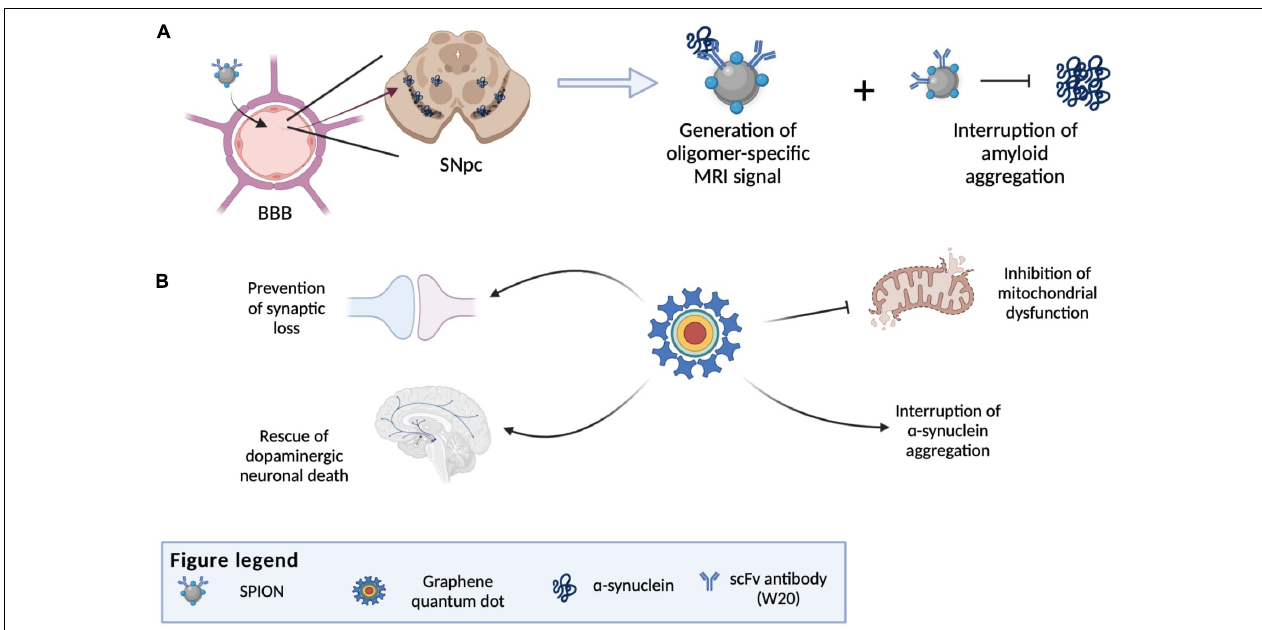
FIGURE 6 | Illustration of various nanotheranostic approaches targeting different stages of PD. (A) Illustration of antibody-conjugated SPION bypassing BBB due to receptor-mediated transcytosis and finally reaching the substantia nigra. SPIONS are able to bind to amyloid and generate an MRI signal (diagnostic) and at the same time interrupt further aggregation of amyloid. (B) Examples of applications of graphene quantum dots (GQDs) in PD, whereby all mechanisms by which GQDs work give rise to an eventual rescue of neuronal death by interrupting α -synuclein aggregation, reducing reactive oxygen species generation and preventing synaptic loss. BBB, blood-brain-barrier; SNpc, substantia nigra pars compacta; SPION, superparamagnetic iron